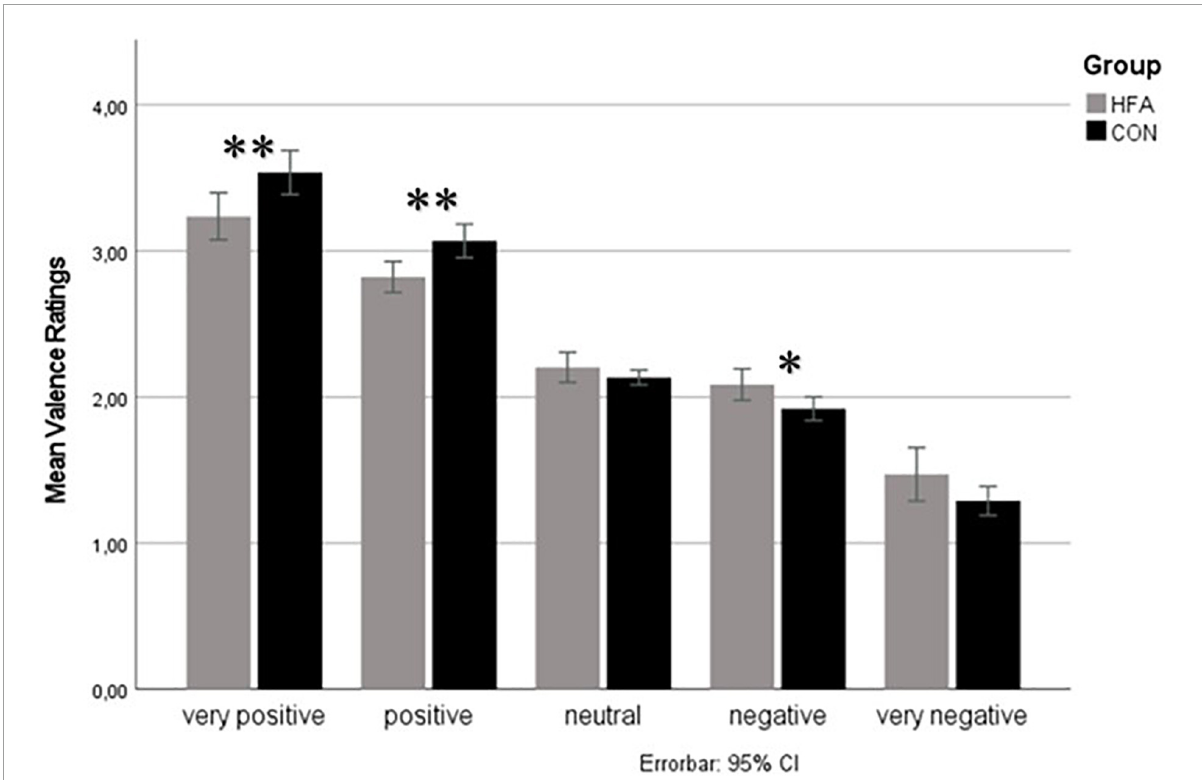
FIGURE2 Valence ratings for different nonverbal valence levels. Mean valence ratings for different levels of nonverbal valence on the y -axis. The gray column represents the high-functioning autism (HFA) group, and the black column the typically developed control group. Errorbars indicate 95%-confidence intervals. Significant group differences are indicated by asterisks (level of significance ∗ < 0.05, ∗∗ < 0.01) Significant differences between the groups in “very positive”, “positive”, and “negative” valence levels. Valence ratings of the HFA group compared to controls are less extremely/more neutrally directed in every